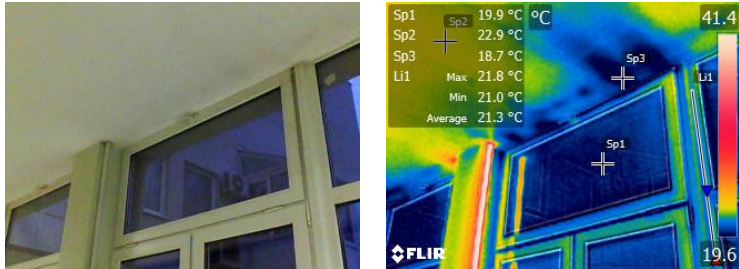
Figure 5. Thermogram of the openings in the outer envelope of the building.